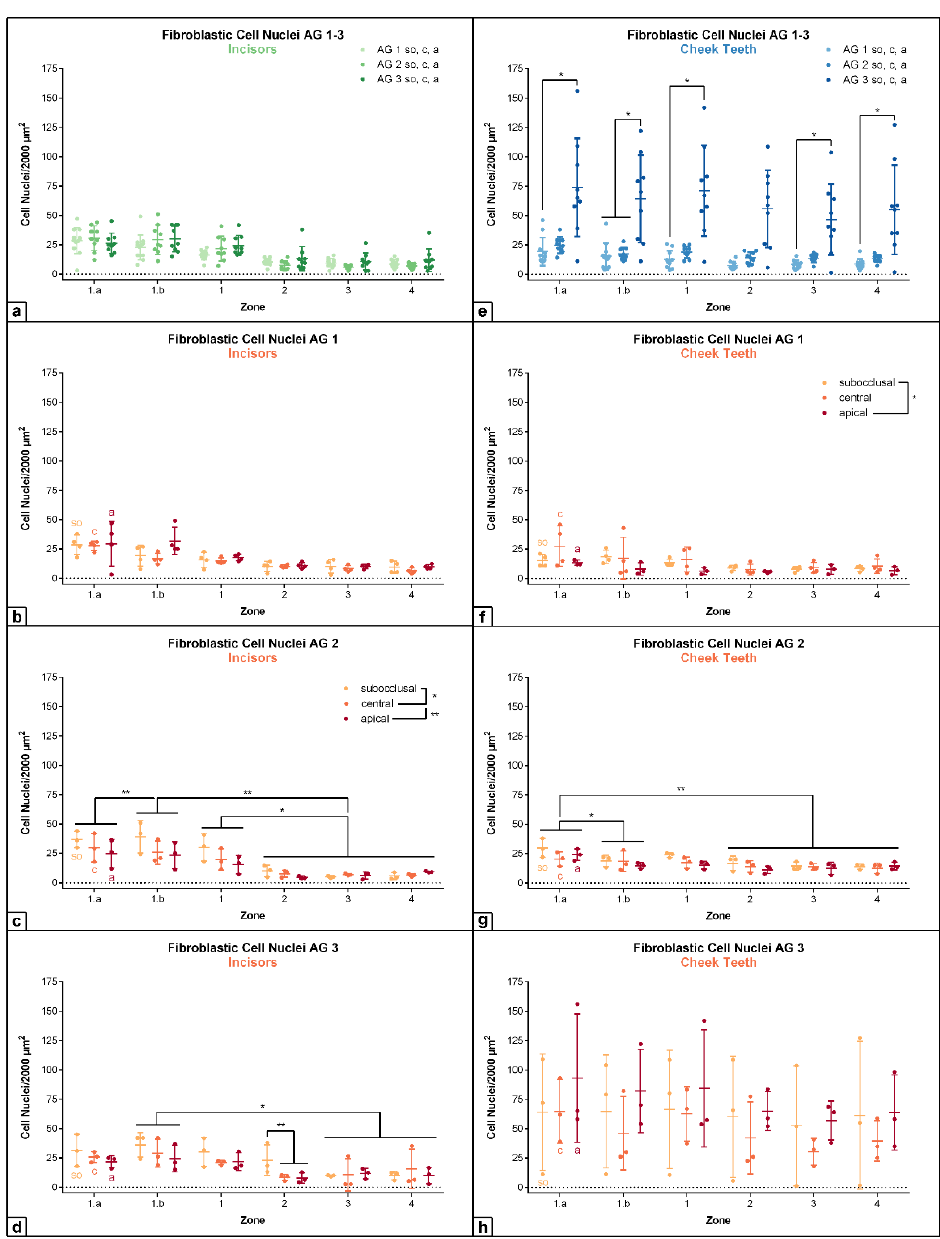
Figure 6. Dot-plot diagram showing the density of fibroblastic cell nuclei (number per 2000µm 2 ) of different age groups (AG 1 to 3) within different zones (zone 1.a to 4). The horizontal levels subocclusal ( so ), central ( c ) and apical ( a ) are shown within the different age groups. Mean was presented as a central horizontal bar and the standard deviation as vertical whiskers. p -values: p ≤ 0.05 (*) and p ≤ 0.01 (**). ( a ) Dot-plot diagram showing the density of fibroblastic cell nuclei in incisors of AG 1, AG 2 and AG 3 (green colors). Horizontal levels ( so , c , a ) are combined within each age group. ( b ) Dot-plot diagram showing the density of fibroblastic cell nuclei in incisors of AG 1 (orange colors). ( c ) Dot-plot diagram showing the density of fibroblastic cell nuclei in incisors of AG 2 (orange colors). ( d ) Dot-plot diagram showing the density of fibroblastic cell nuclei in incisors of AG 3 (orange colors). ( e ) Dot-plot diagram showing the density of fibroblastic cell nuclei in cheek teeth of AG 1, AG 2 and AG 3 (blue colors). Horizontal levels ( so , c , a ) are combined within each age group. ( f ) Dot-plot diagram showing the density of fibroblastic cell nuclei in cheek teeth of AG 1 (orange colors). ( g ) Dot-plot diagram showing the density of fibroblastic cell nuclei in cheek teeth of AG 2 (orange colors). ( h ) Dot-plot diagram showing the density of fibroblastic cell nuclei in cheek teeth of AG 3 (orange colors).